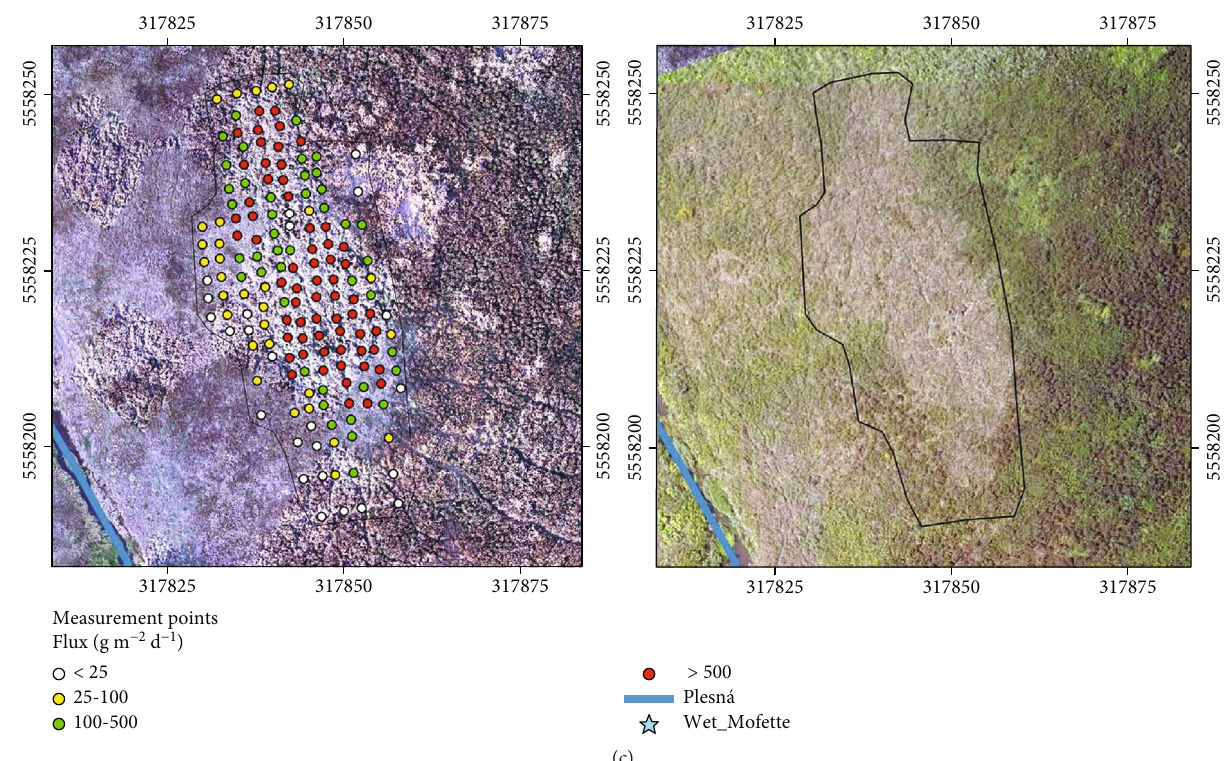
Figure 6: Soil CO gas fl ux for (a) MERX, (b) MZ, and (c) MN. Left: October 2018 drone image with partitioned populations. Right: August 2 2017 drone